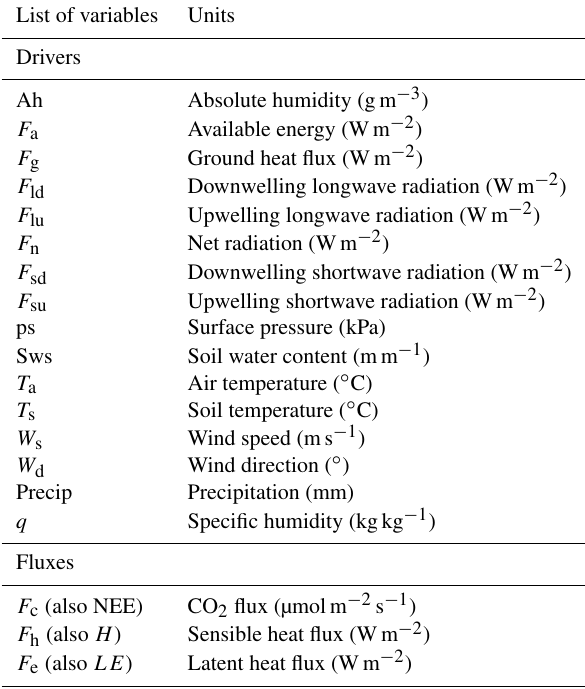
Table 2. List of variables and their units used in this research, in- cluding the three main fluxes and their environmental drivers.